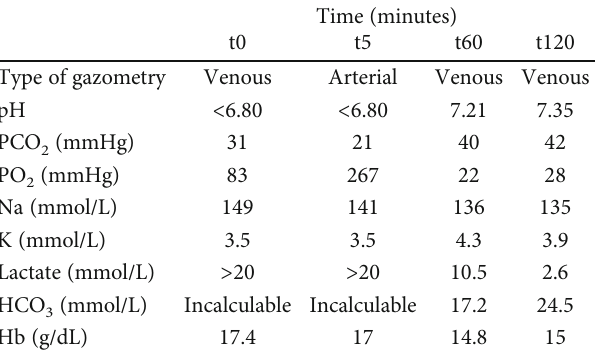
Table 1: Cinetic of gazometry parameters. Time (minutes) Type of